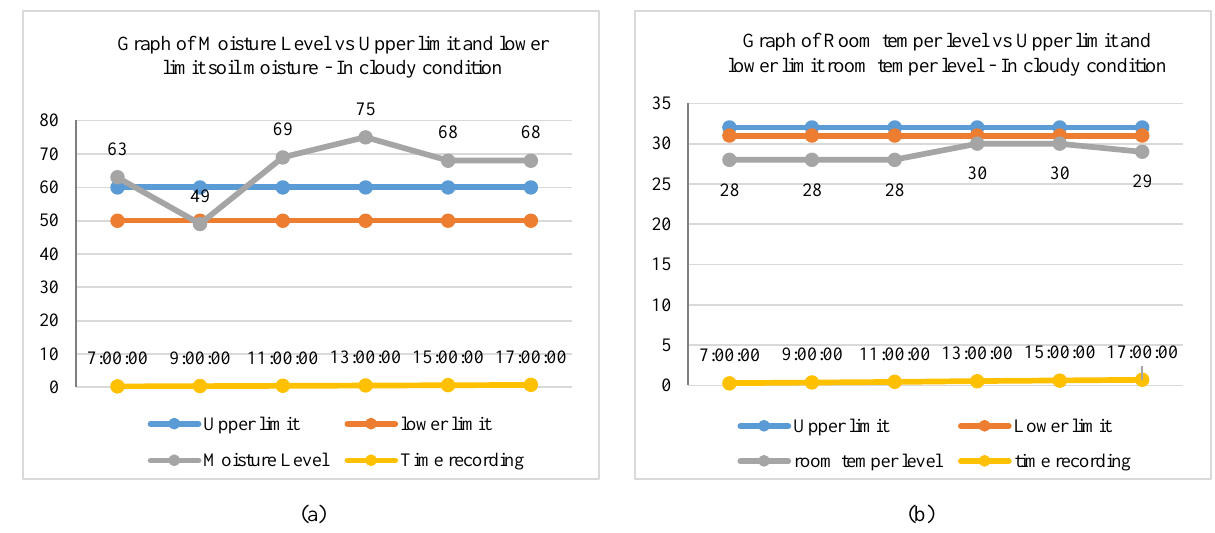
Figure 7. (a) Monitoring page in Android; (b) Graphic data page in Android.